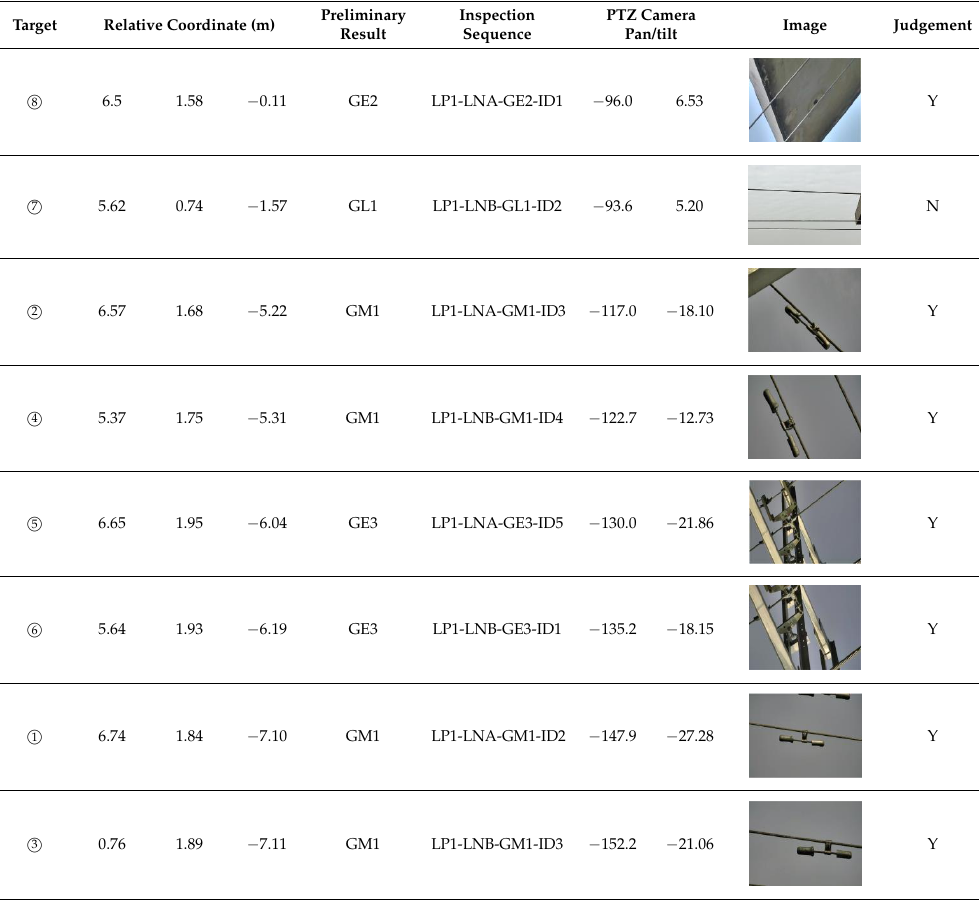
Figure 18. Classification results: ( a ) classification point clouds of Line 1; ( b ) classification point clouds of Line 2. All waiting-inspection targets are numbered along the line relative to the reference point, generating the inspection sequence. The PTZ camera is autonomously adjusted to take images that are stored into the inspection database for inspection judgement. Table 4 gives inspection information on Lines 1 and 2. Table 4. Information of inspection targets on Lines 1–2.